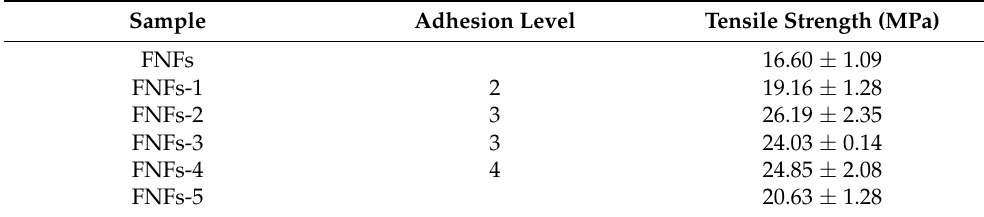
Table 3. Mechanical properties of the FNFs and coated